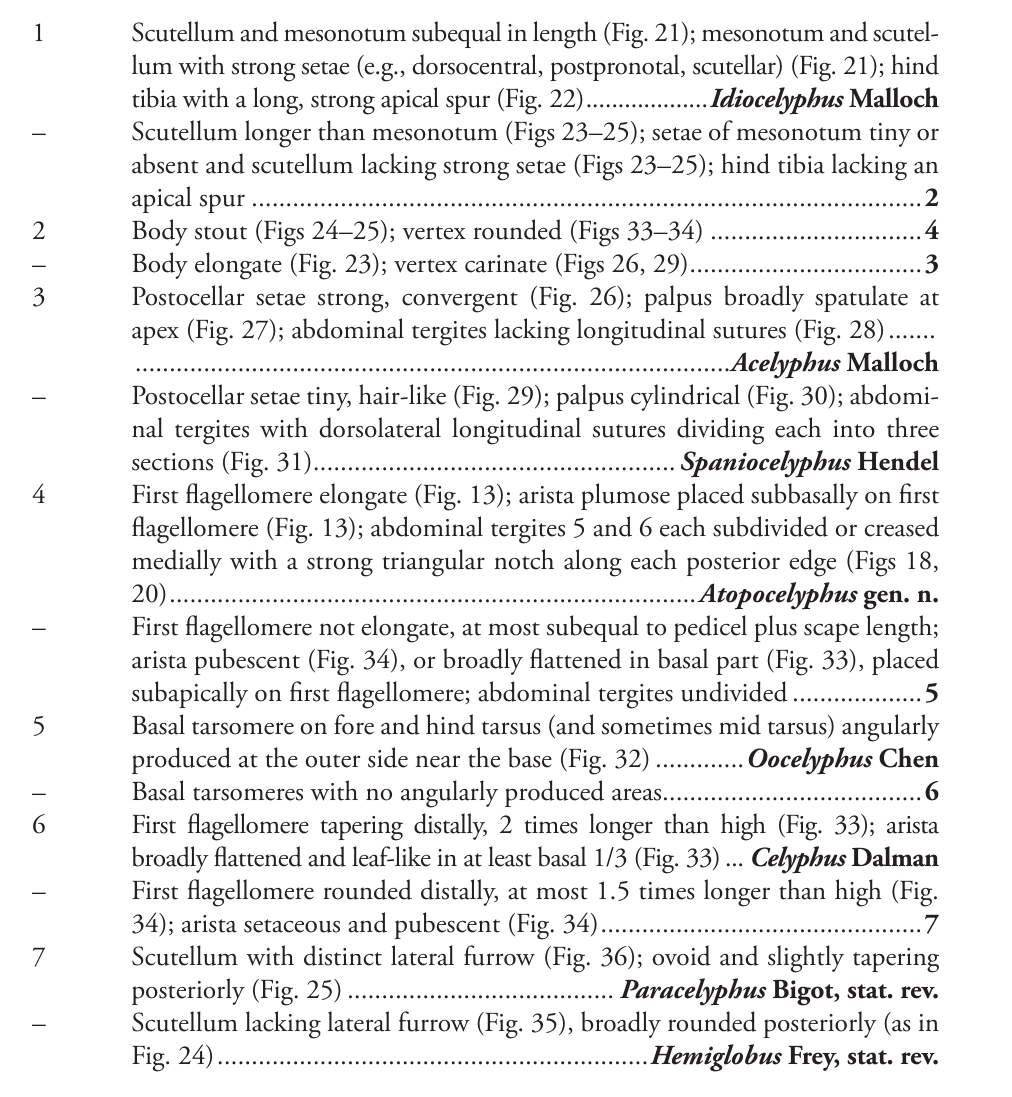
Scutellum and mesonotum subequal in length (Fig. 21); mesonotum and scutel- lum with strong setae (e.g., dorsocentral, postpronotal, scutellar) (Fig. 21); hind tibia with a long, strong apical spur (Fig. 22) ................... Idiocelyphus Malloch